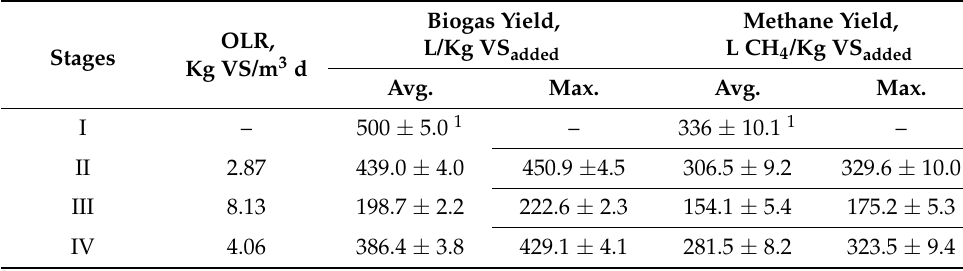
Table 6. Average and maximum yield of biogas and